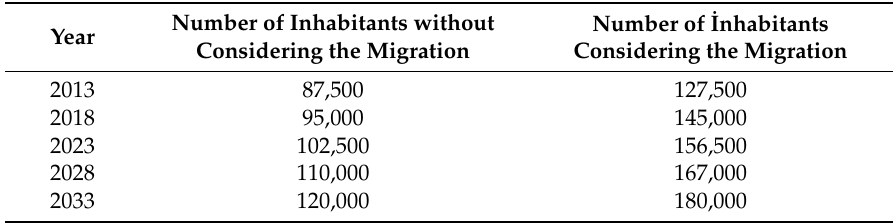
Table 4. Projection of the number of inhabitants in the area of interest without and with the consideration of migration